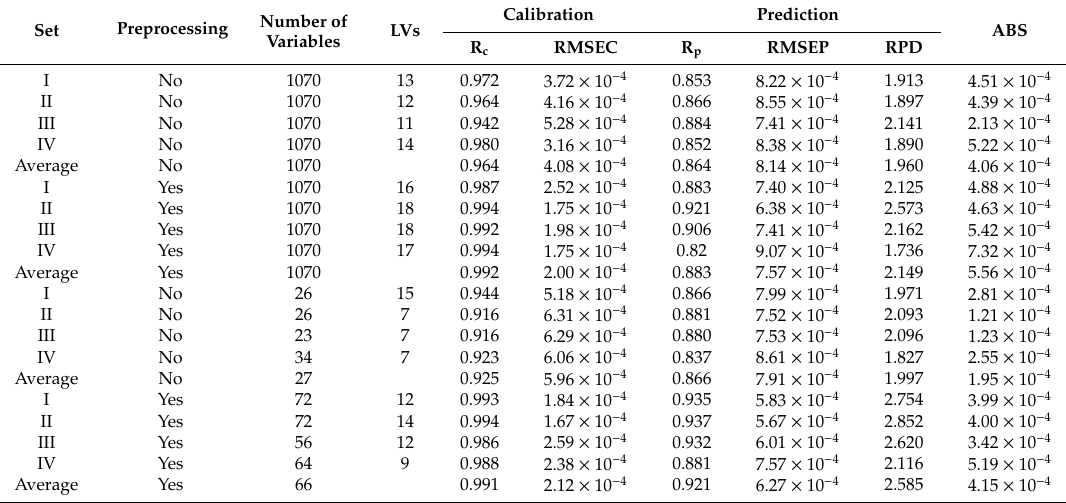
Table 2. Pesticide residue predictions given by the PLSR models using combined LIBS and HSI data, both with all variables (upper half) and with only optimal variables (lower